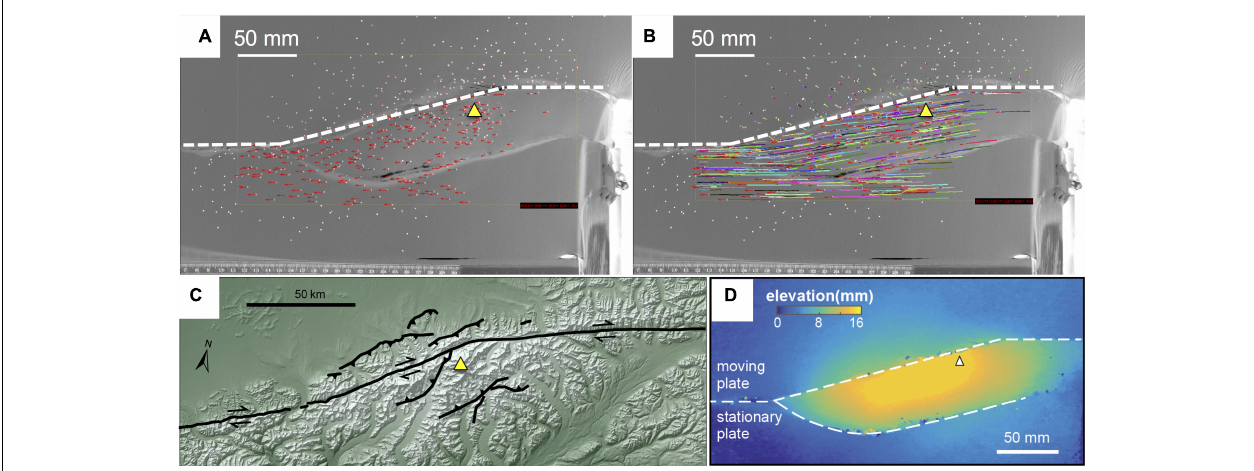
FIGURE 5 | Particle tracking velocimetry (PTV) showing (A) incremental and (B) cumulative advective transport around a physical model designed to simulate the Mount McKinley restraining bend along the Denali fault zone. (C) Digital elevation model of the Denali fault with Denali peak (triangle) and fault trace indicated. (D) Cumulative uplift map revealed by